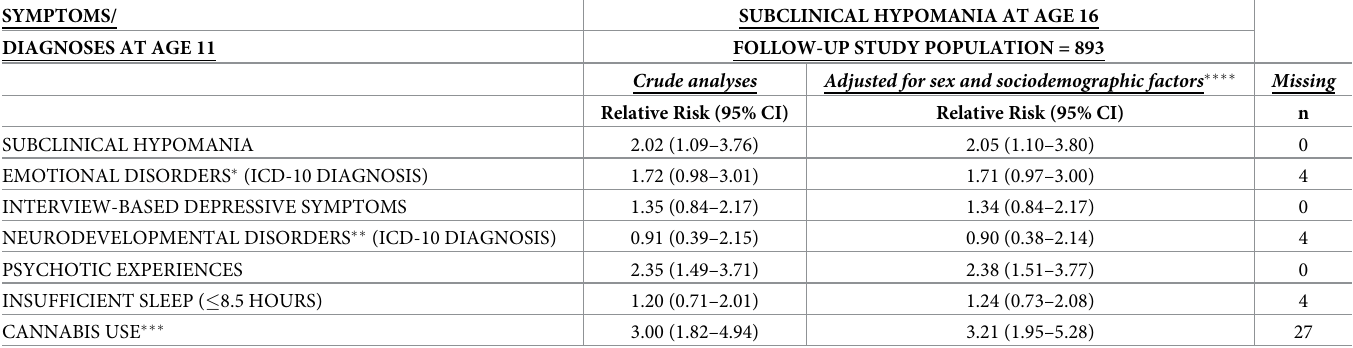
Table 4. The association between symptoms/ diagnoses at age 11 and subclinical hypomania at age 16.